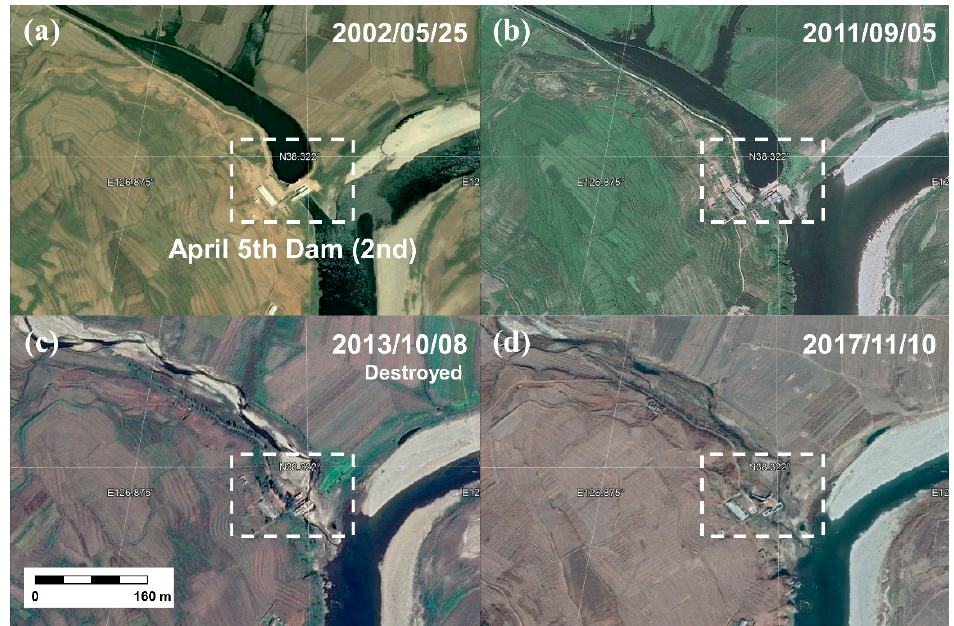
Figure 3. Images of the Second April 5th Dam from 2002 to 2017 (Lat 38.3214° N, Lon 126.8783° E, map data ©2019 Google, Maxar Technologies).